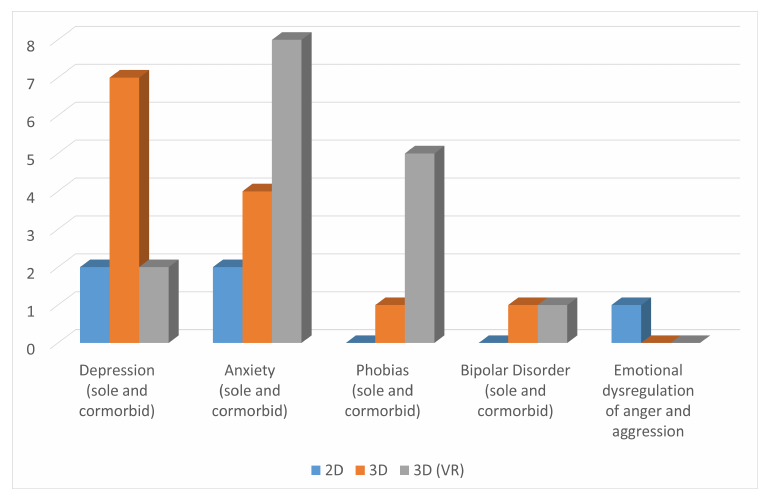
Figure 3. Dimensionality of the games used for each affective